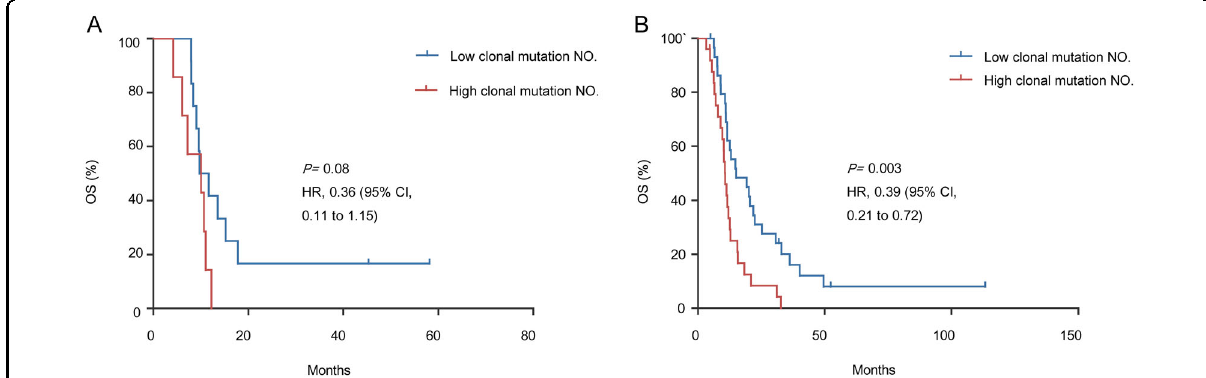
Fig. 4 Clonal mutation NO. in relation to the outcome of both SCCE and SCLC. A Kaplan − Meier analysis of overall survival (OS) in SCCE patients with more and less clonal mutation NO. (HR, 0.36; 95% CI, 0.11 – 1.15; P = 0.08). B Kaplan − Meier analysis of overall survival (OS) in SCLC patients with more and less clonal mutation NO. (HR, 0.39; 95% CI, 0.21 – 0.72; P = 0.003).